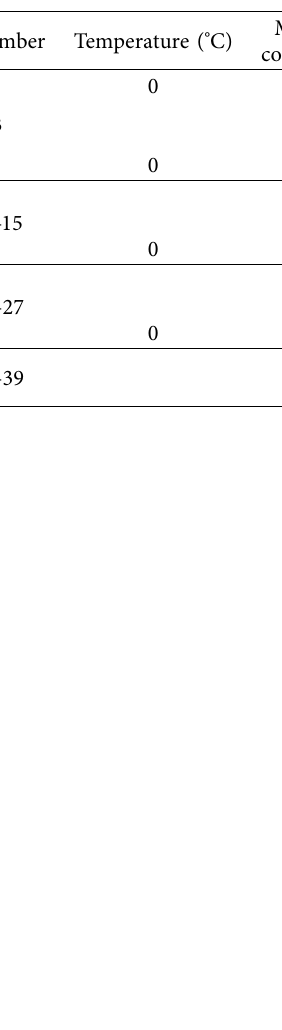
Table 3: Relationship between moisture content and bond strength.